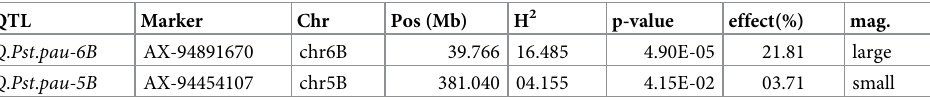
Table 6. QTLs identified and their association with the KASP Markers based on significant difference by Kruskal- Wallis test.